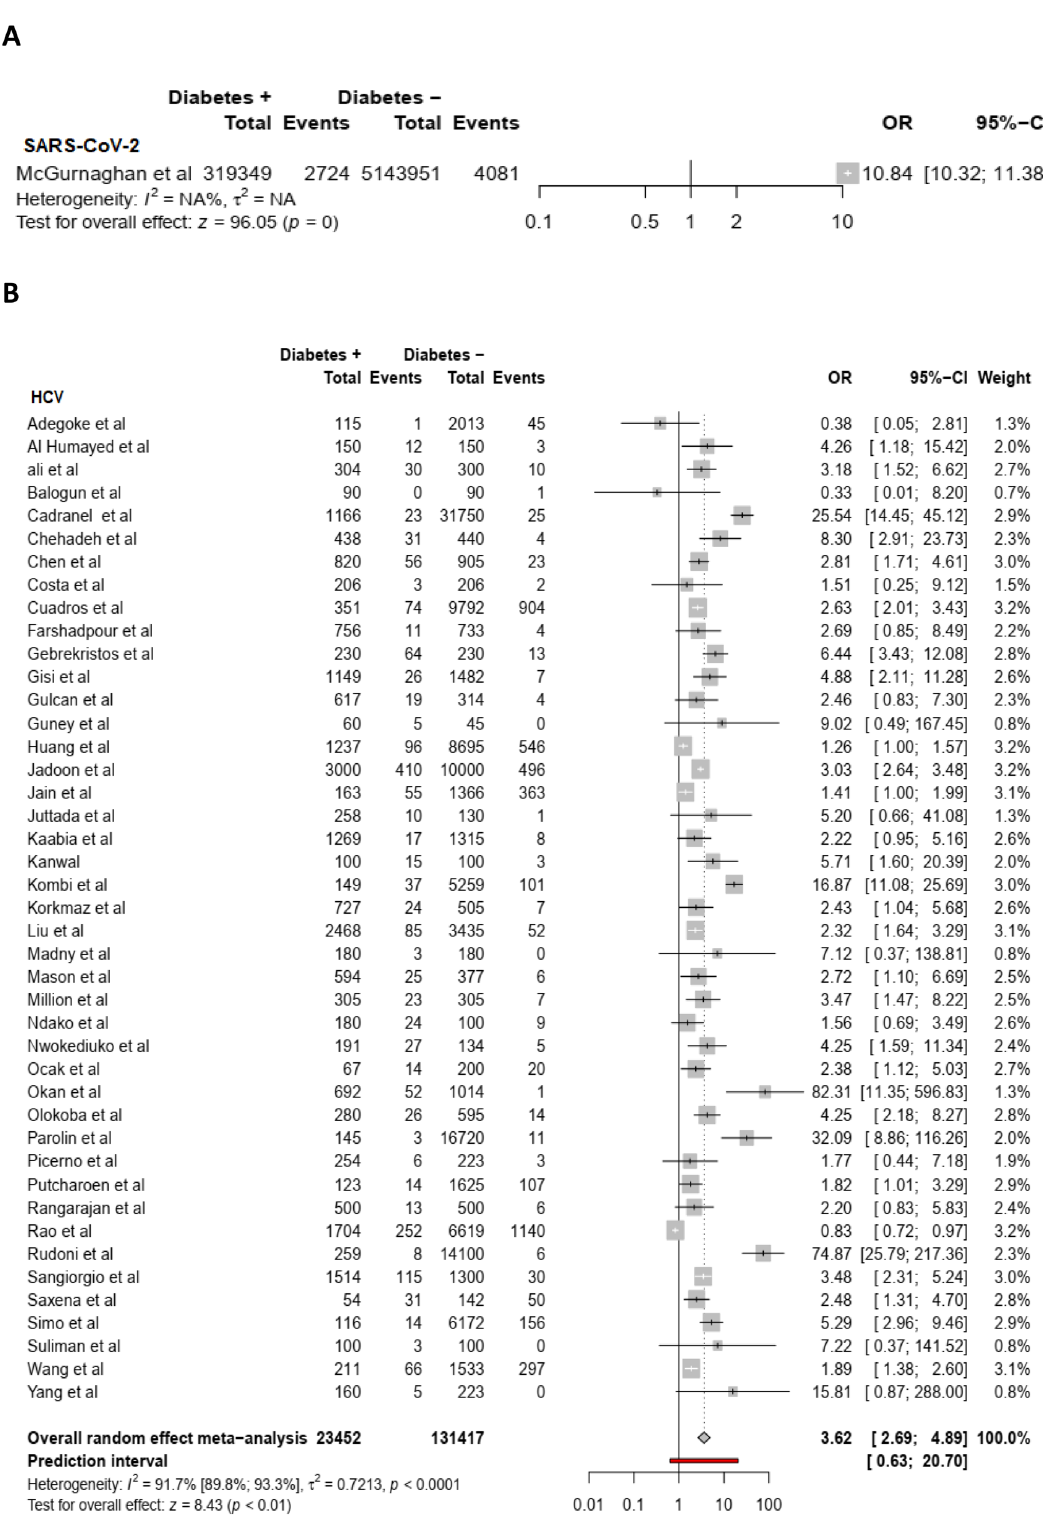
Figure 1. Meta-analysis of the association between SARS-CoV-2 ( A ), HCV ( B ) and non-autoimmune diabetes